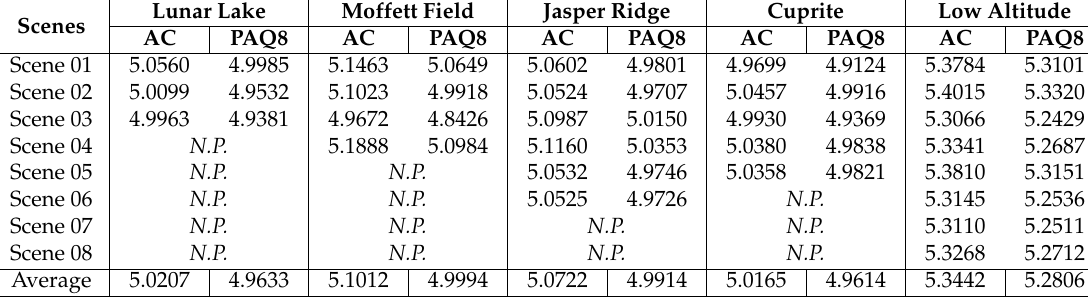
Table 2. Achieved results by using the following parameters: N “ 8, B “ 1. ( N.P. indicates that the scene is not